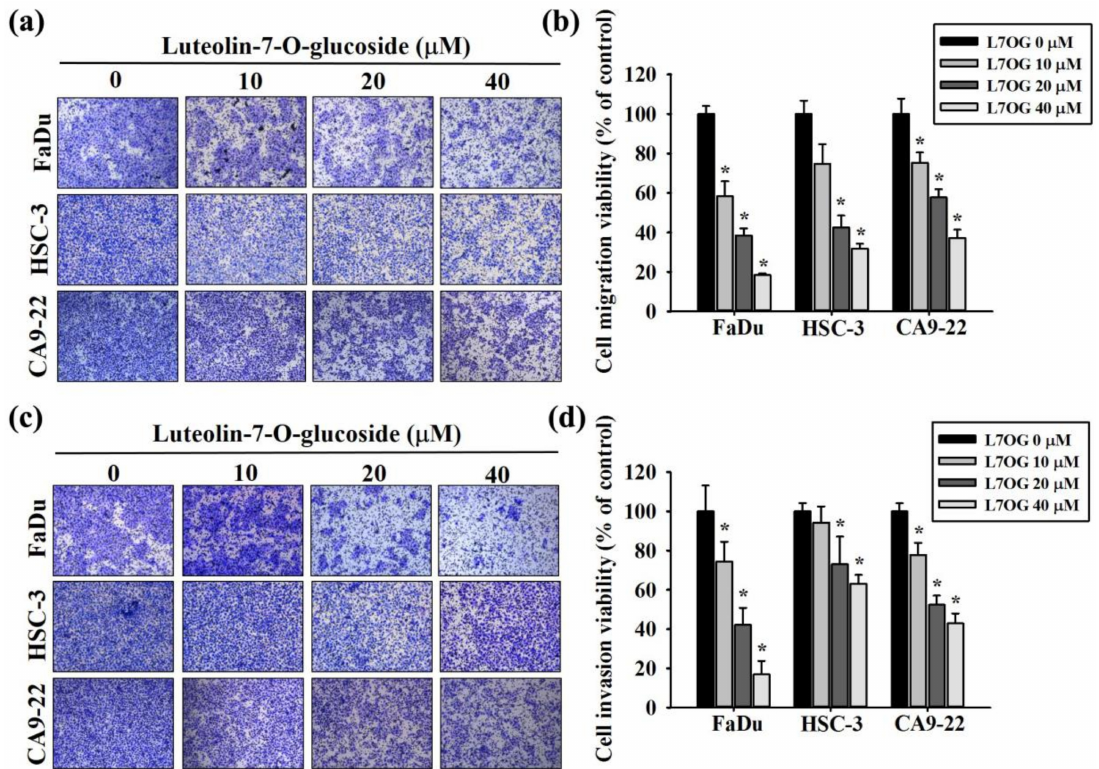
Figure 3. Luteolin-7-O-glucoside inhibits cell migration and invasion inhuman oral cancer cells. The e ff ect of luteolin-7-O-glucoside treatment on cell migration ( a ) and invasion ( c ) was measured using trans-well assay in FaDu, HSC-3, and CA9-22 cells. The percentages of cells in migration and invasion assays are shown in ( b ) and ( d ), respectively. The values are represented as mean ± SD of at least three independent experiments. * p < 0.05, compared with the control